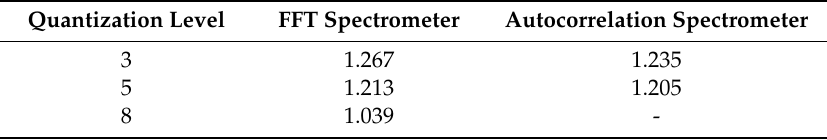
Figure 20. Backend signals under different quantization levels and corresponding sensitivities: ( a ) Analog; ( b ) 3-bit; ( c ) 5-bit; ( d ) 8-bit. The left figures represent output signals after quantization, and the right figures represent corresponding differences between input radiance and output radiance. Table 3. Deterioration ratio η under different quantization levels.